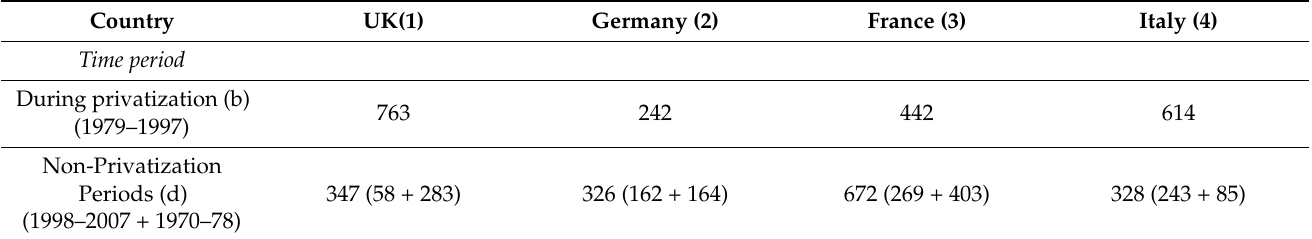
Table A4. Robustness test for Table 4 Total and per Year Number of Fatalities from Multi-fatality Disasters (Excluding Air Ac-cidents),